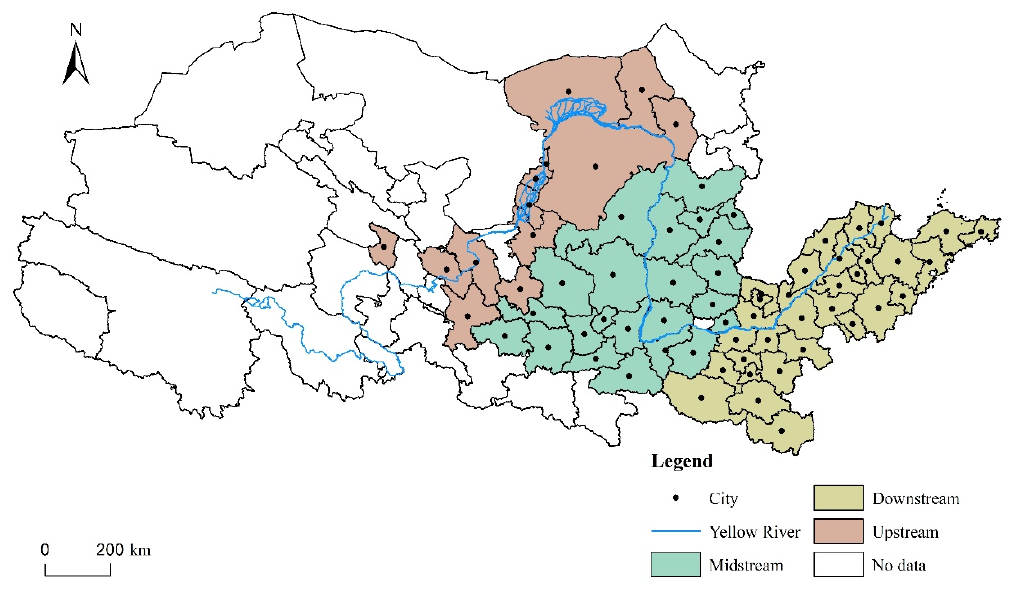
Figure 1. Sample area: the Yellow River Basin.